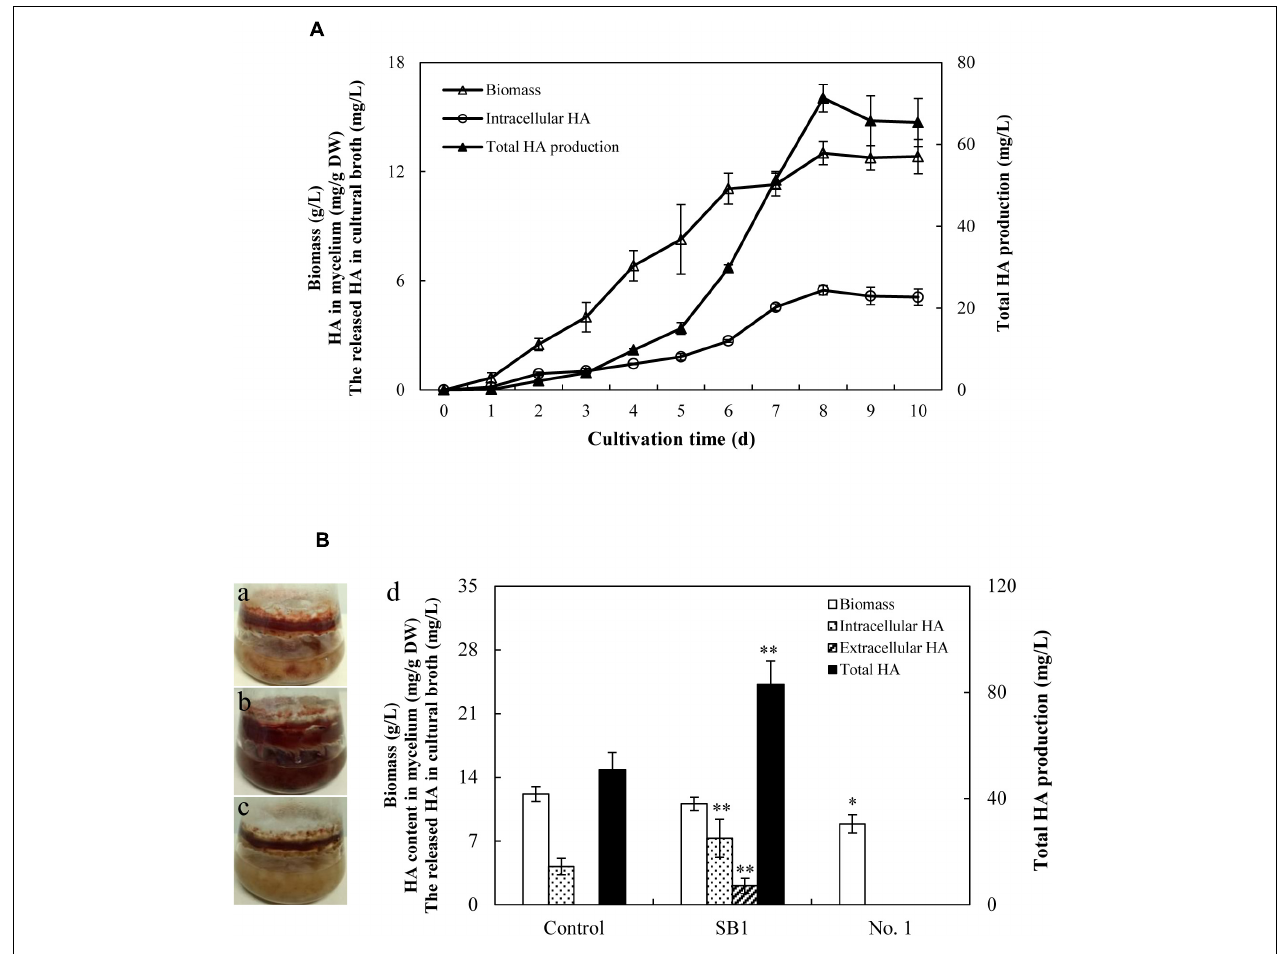
FIGURE 6 | (A) Time profiles of growth and HA accumulation in submerged culture of S9 strain. (B) Observation of submerged cultures of Shiraia sp. S9 with or without live bacterial cells on day 8. (a) Control group. (b) Live P. fulva SB1 treatment. (c) B. cereus No. 1 treatment. (d) The effect of live bacteria on hyphal biomass, intracellular HA, extracellular HA, and total HA production in submerged cultures of Shiraia sp. S9. The bacteria at 100 cells/ml were added to the cultures on day 4. Values are mean ± SD from three independent experiments. ∗ p < 0.05, ∗∗ p < 0.01 versus control